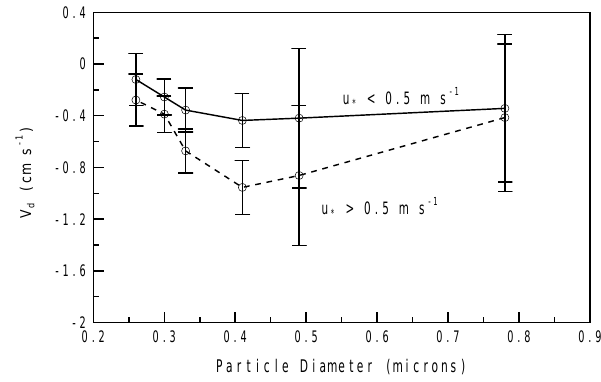
Fig. 7. Size dependence of aerosol deposition velocity (corrected for hygroscopic growth and WPL). Bars indicate ± the average counting error for single 30min fluxes (negative V d is